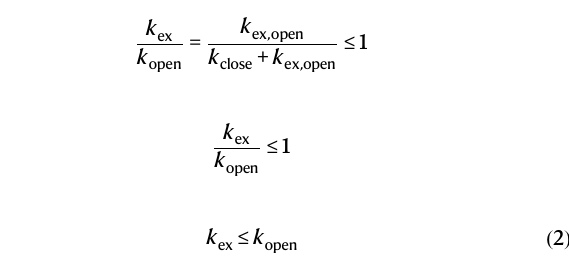
(Table 1, Fig. 2d). The order of the magnitude of the k in (cid:3) cell